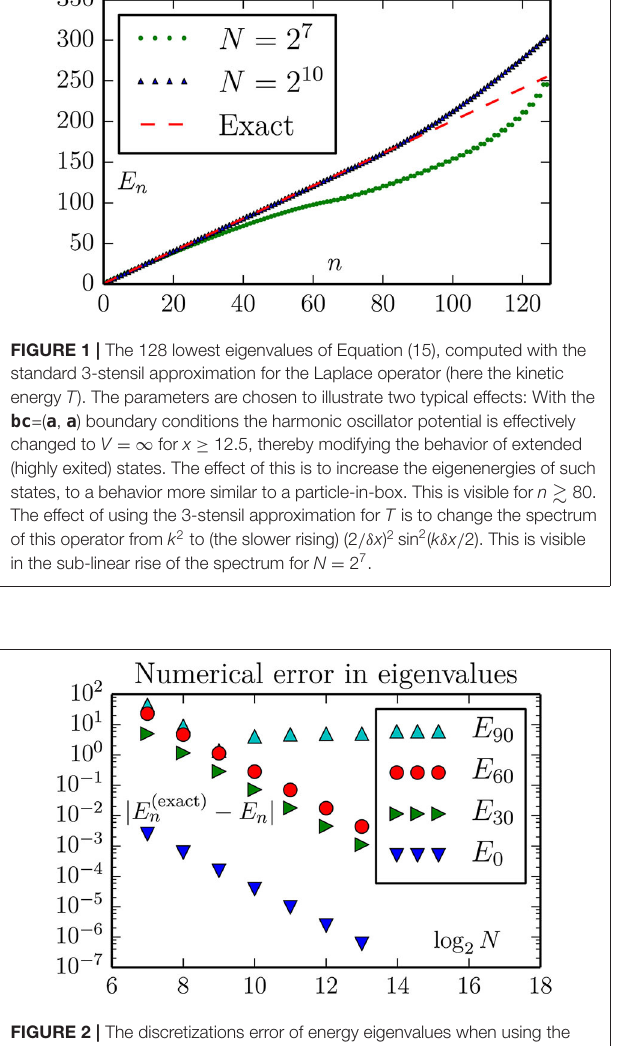
FIGURE 2 | The discretizations error of energy eigenvalues when using the standard 3-stensil approximation for the one-dimensional Laplace operator (here the kinetic energy T ). There is no improvement in E 90 beyond a certain lattice size N , because the corresponding oscillator state is too large for the geometric region. Hence, for improved accuracy of higher eigenvalues one should instead increase the xe , while maintaining xo states the improvement is consistent with the expectation of an error proportional to δ x 2 . This predicts an accuracy improvement of magnitude 2 12 4,096 when the number of lattice sites increases from N = N 2 13 for a fixed geometry. The eigenvalues are computed by the dense = matrix routine eigvalsh from scipy.linalg .